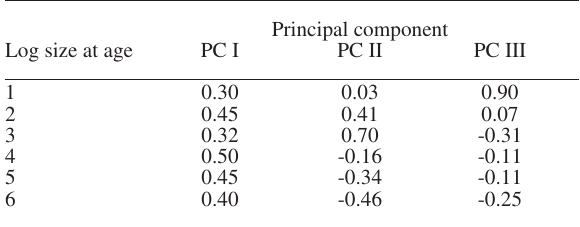
Table 1. – Eigenvectors for the first three components in the prin- cipal component analysis of logarithmic sizes (cm TL) at ages 1 to 6 for cod in 3Ps.